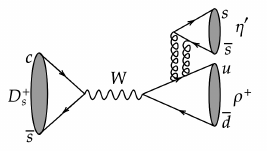
Figure 2 . Hairpin-topological diagram for D +